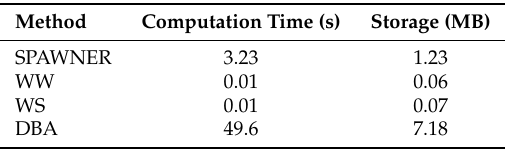
Table 4. Time- and memory-consumption of compared time-series augmentation